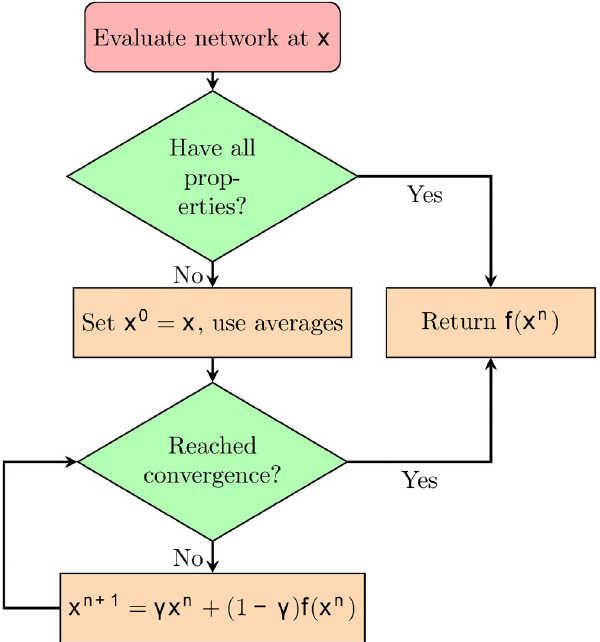
Fig 2. Data imputation algorithm for the vector x. After checking the missing properties of entries, we set x 0 = x , and replace all the missing data by averages from the training data set. We then iteratively compute x n +1 as a function of x n and f ( x n ) until we reach convergence after n